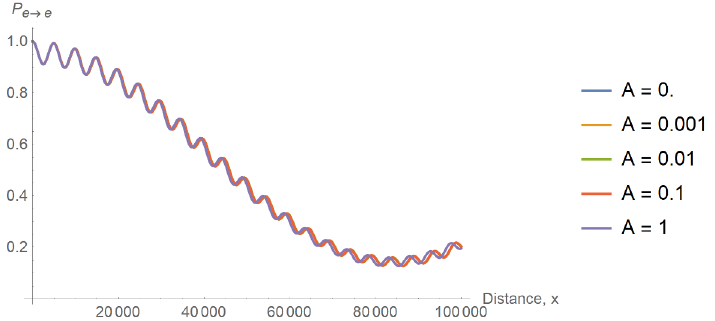
Figure 2. Plot of electron neutrino survival probability, P e → e , as a function of distance, x , for various nonlinearity strengths (di ff erent values of A ). A larger A value indicates a stronger nonlinearity.